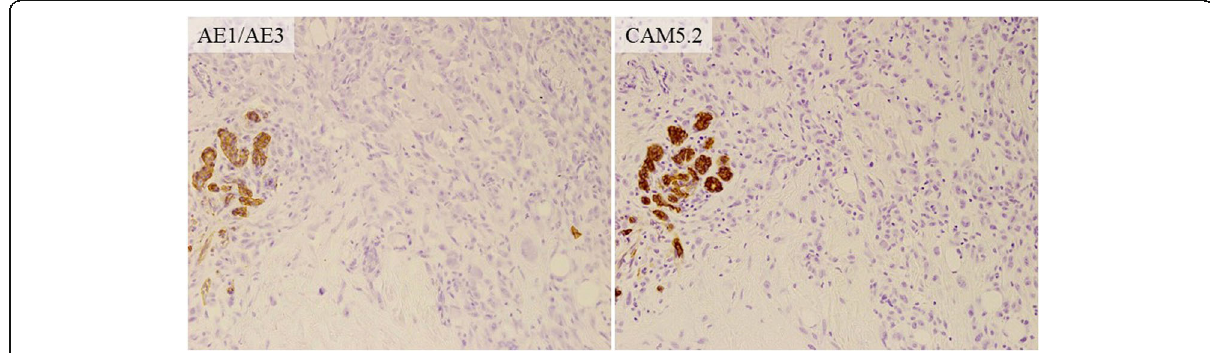
Fig. 6 Immunohistochemistry. (× 200) The atypical cells were negative for AE1/AE3 and CAM5.2, while the residual normal breast tissue on the left side was positive for these